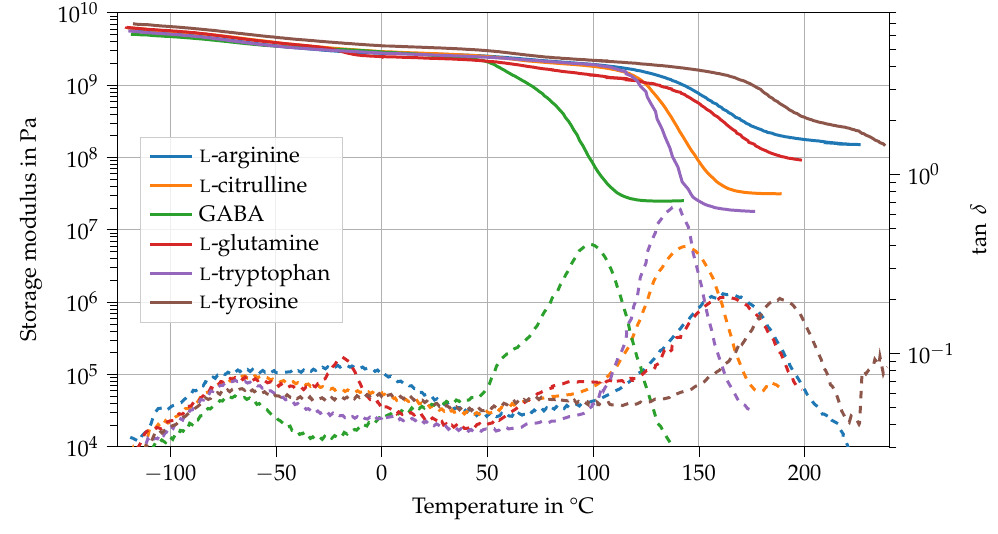
Figure 3. Dynamic mechanical analysis of amino-epoxides between T = − 120°C and 240°C.